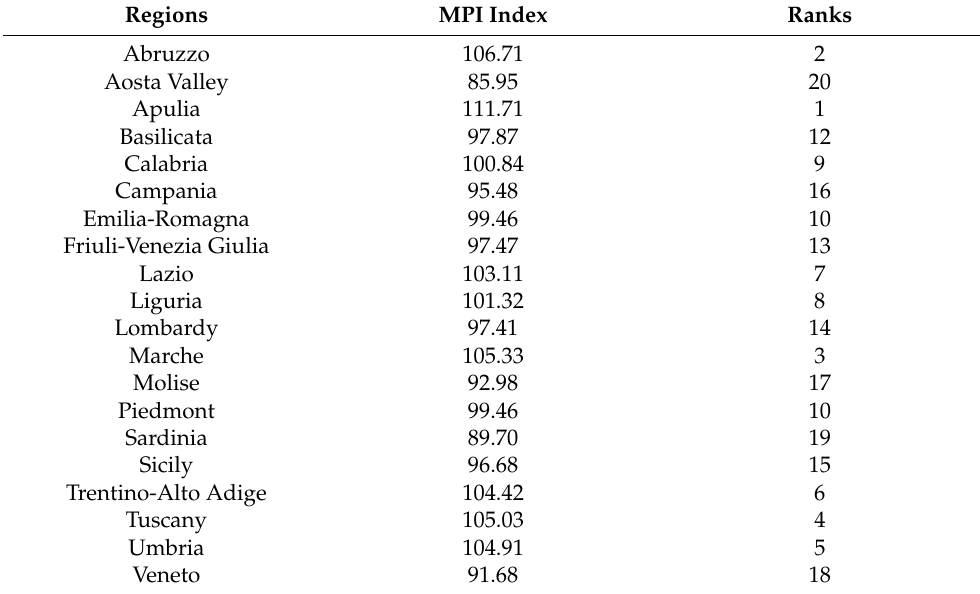
Table 4. MPI Trust in Institutions Index.